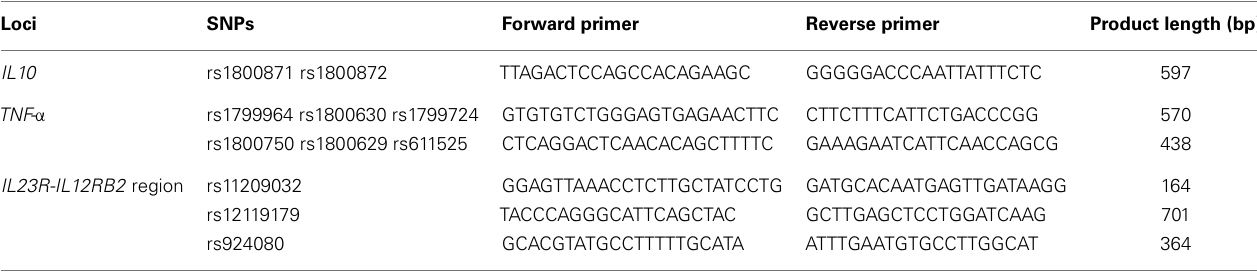
Table 1 | Primers sequence and length product.